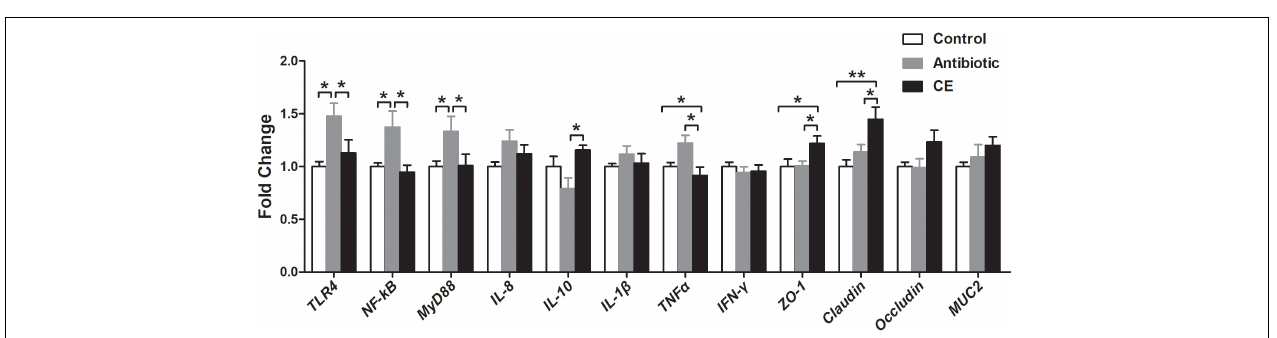
FIGURE 6 | Effect of the dietary supplementation with citrus extract on the concentrations of amino acid fermentation products in the cecal digesta of Chinese yellow-feathered broilers: (A) ammonia, (B) phenolic and indole compounds, and (C) biogenic amines. The values are means ± SEM. Asterisks indicate statistical differences between different groups (one-way ANOVA with a Tukey post hoc test): ∗ P < 0.05. CE, citrus extract.